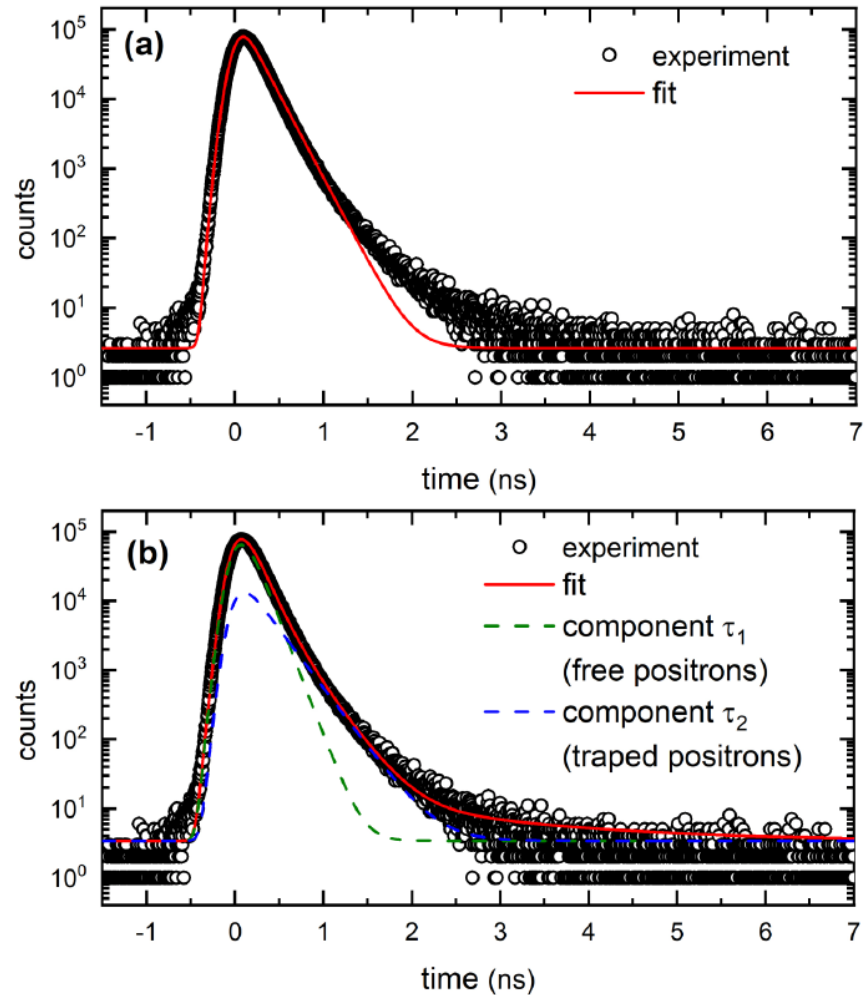
Figure 3. An example of positron lifetime spectrum measured for the TEH1 sample and energy of incident positrons E = 10 keV. Solid line shows fit of the spectrum by model function. ( a ) Single- component fit yielding the mean positron lifetime; ( b ) Two-component fit considering contribution of free positrons (lifetime τ 1 ) and positrons trapped at defects (lifetime τ 2 ). Individual components are plotted by dashed lines.